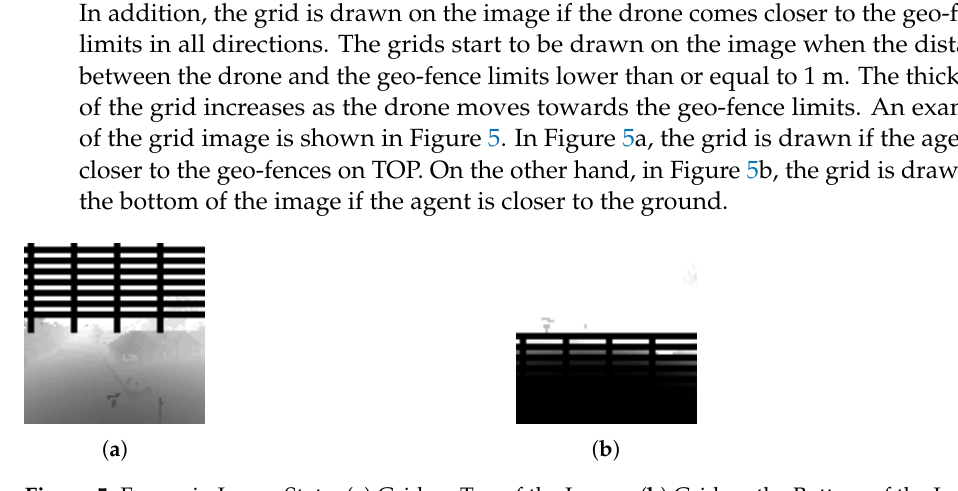
Figure 4. Depth Image.